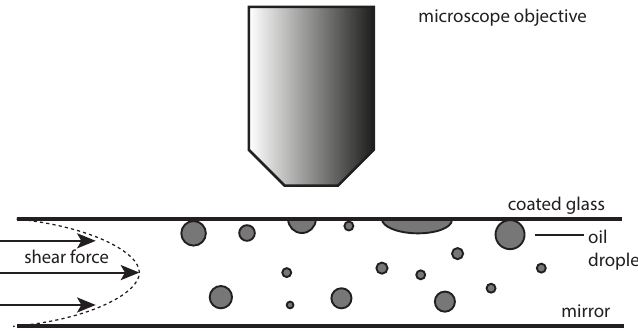
Figure 1. Schematic representation of the flow cell setup under the microscope. The distance h between the mirror and the replaceable upper glass slide can be changed. The shear force is obtained by pumping a solution through the flow cell